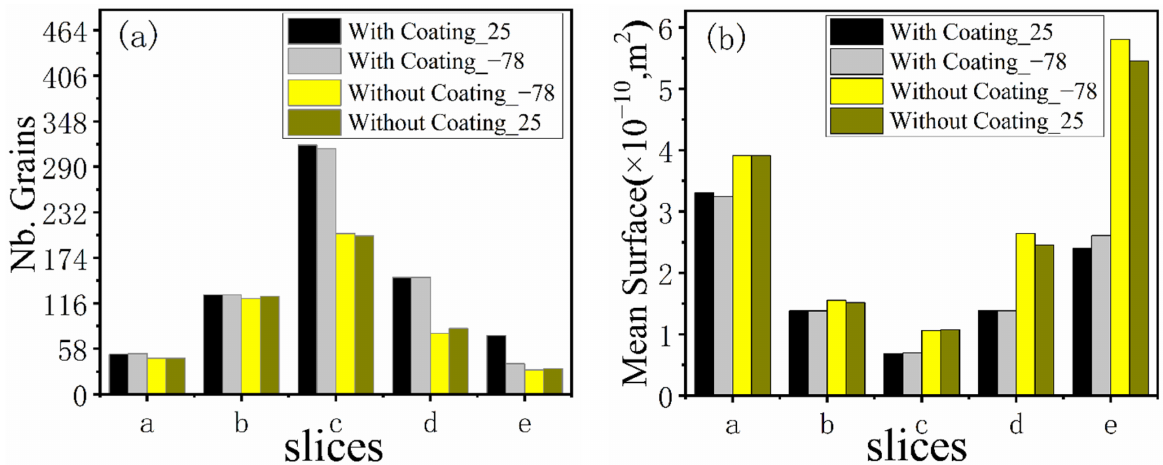
Figure 16. Number grains ( a ) and mean surface ( b ) of different axial sections.